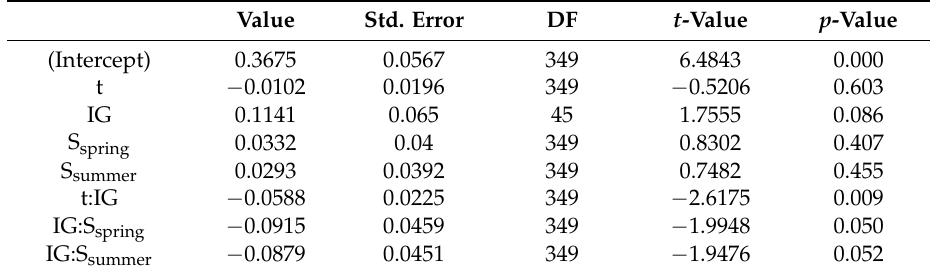
Table A4. Summary of interaction analyzes logCortisol [ µ g/L].